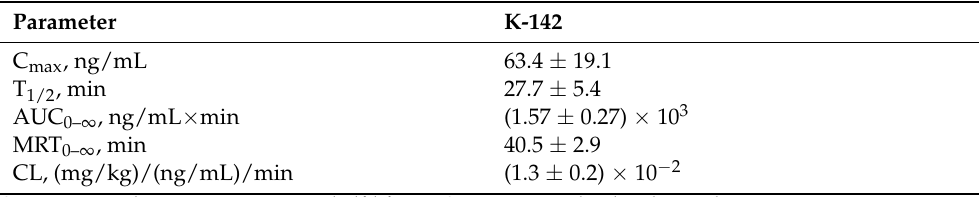
Table 1. Pharmacokinetic parameters (mean values ± SEM) of the agent K-142 after oral administra- tion to mice (20